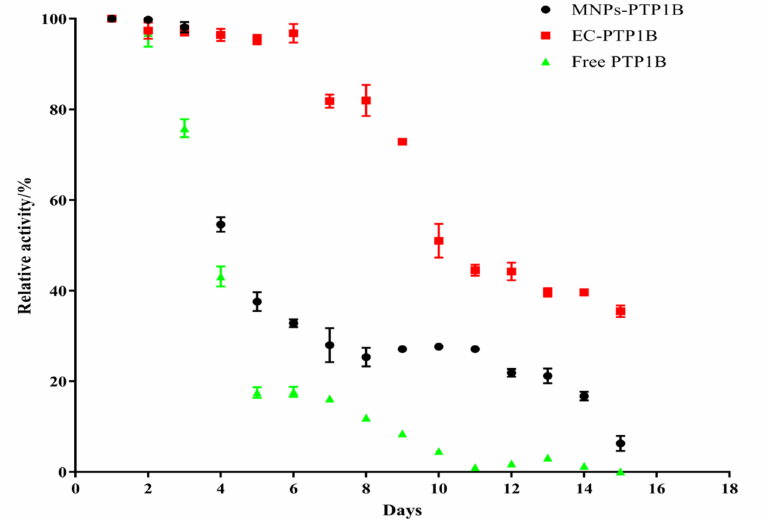
Figure 4. Stability of free PTP1B, MNPs-PTP1B, and